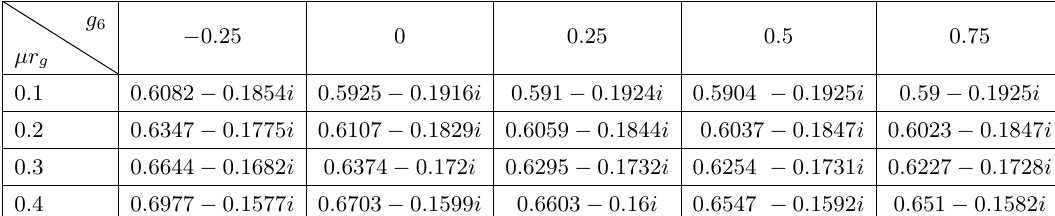
Table 4 . Frequencies ωr g of the fundamental ( n = 0) , first multipole ( ‘ = 1) polar (scalar) QNMs.